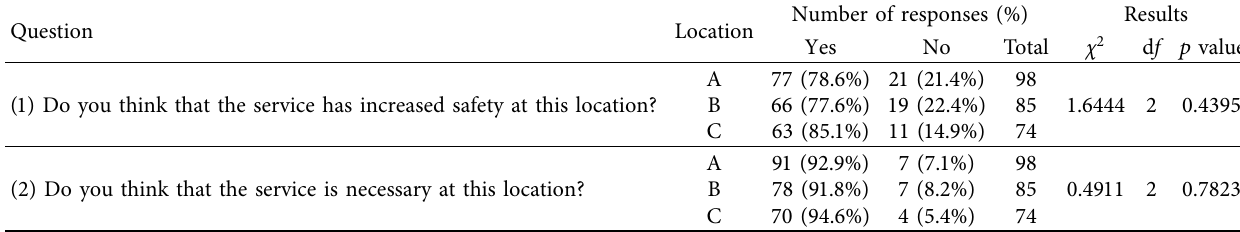
Table 5: Chi-square test results.